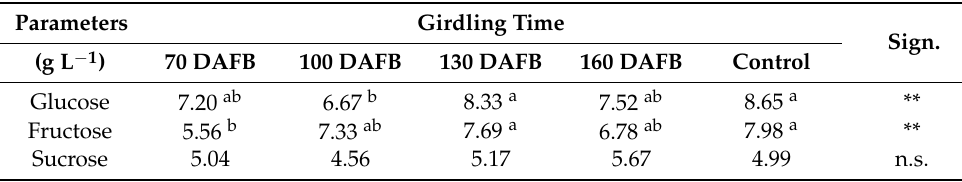
Table 6. Effects of girdling time on the sugar profile.